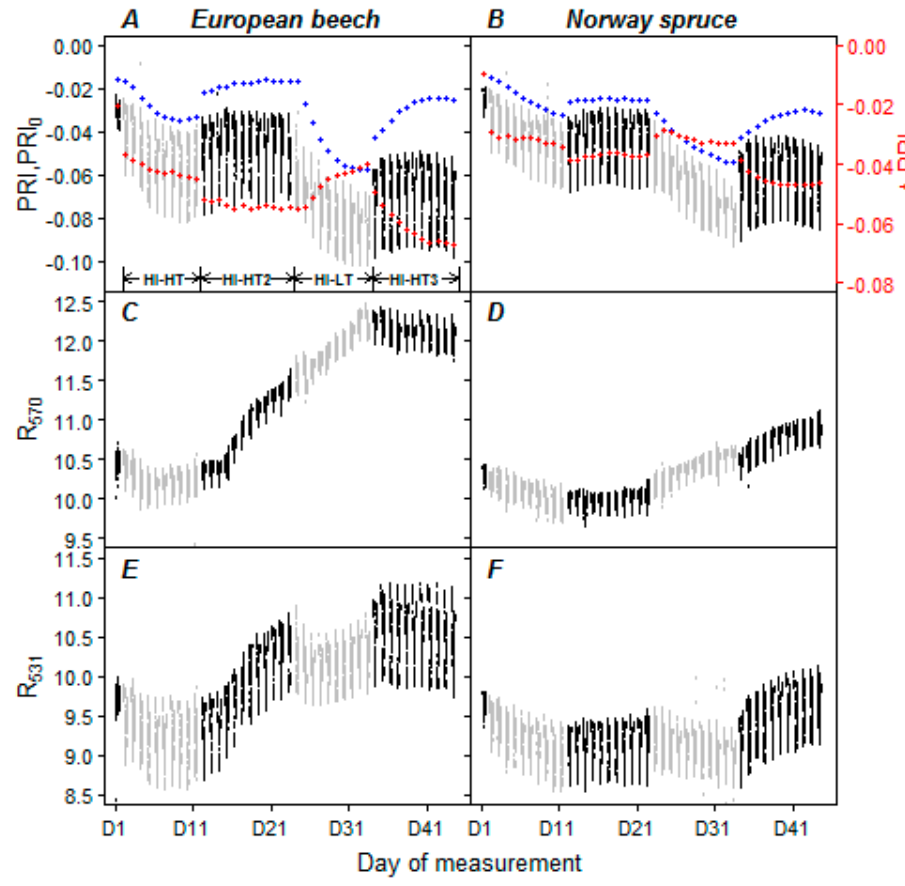
Figure 7. Dynamics of changes in photochemical reflectance index (PRI; black or grey points), reference PRI (PRI 0 ; blue points), and differential PRI ( ∆ PRI; red points) in response to five consecutive regimes of irradiation and temperature (LI–LT, HI–HT, HI–HT2, HI–LT, and HI–HT3) in European beech ( A ) and Norway spruce ( B ) saplings. Alternations between black and grey indicate different regimes of photosynthetically active radiation (PAR) intensity and temperature. Dynamics are for reflectance factor at 570 ( C , D ) and 531 nm ( E , F ) for beech and spruce saplings,